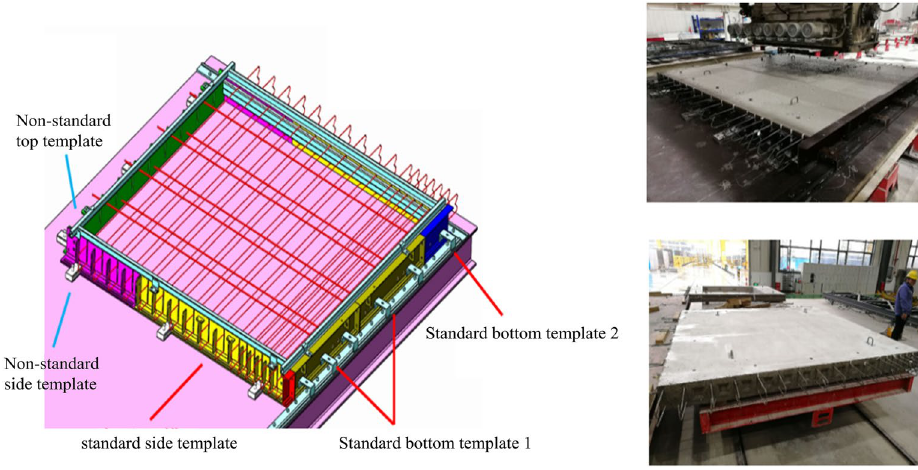
Figure 14. Mould combination diagram.